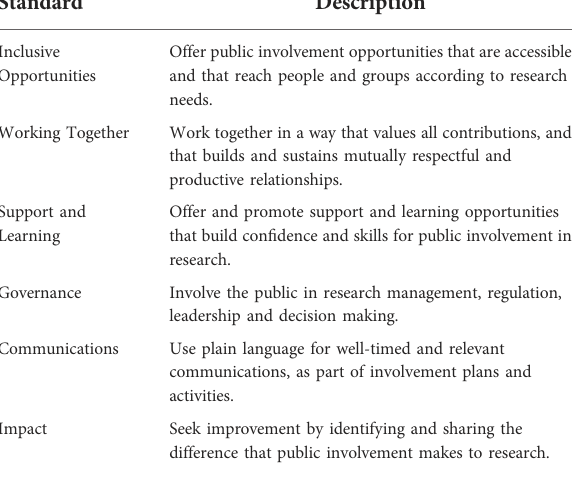
TABLE 1 NIHR standards for public involvement